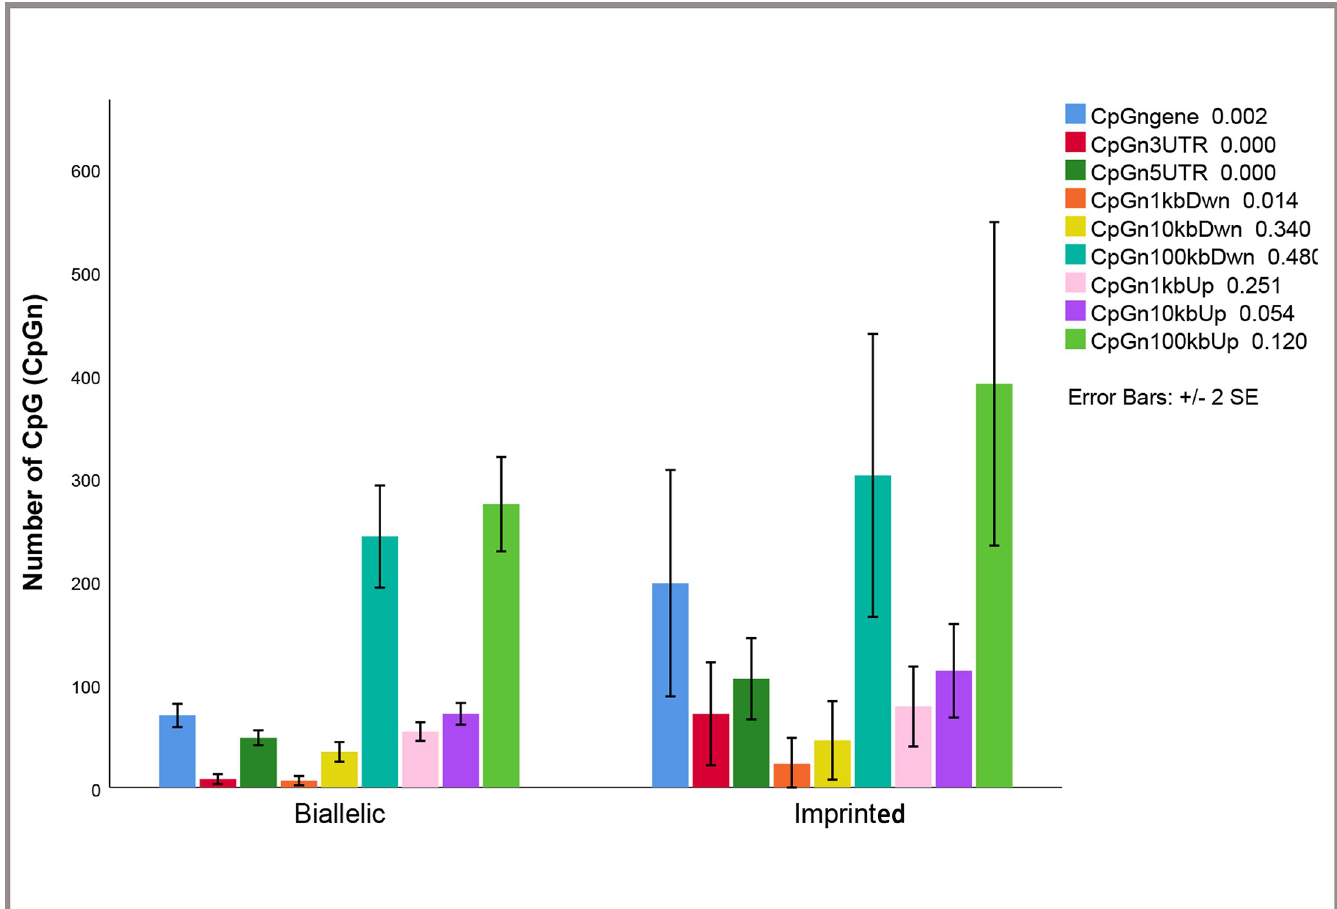
Fig 4. Bar plot of number of CpG (CpGn) in imprinted (M) and biallelic (BI) expressed genes. As shown in the bar plot number of CpG was different between imprinted and biallelic expressed genes in some studied region.